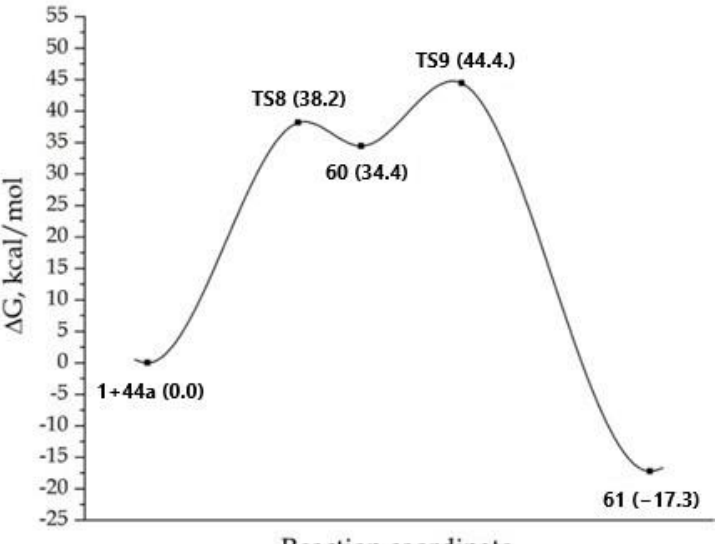
Figure 6. MEP for the reaction concerning the formation of adduct 61 . The total energy of the starting reagents 1 and 44а was taken as the reference point.